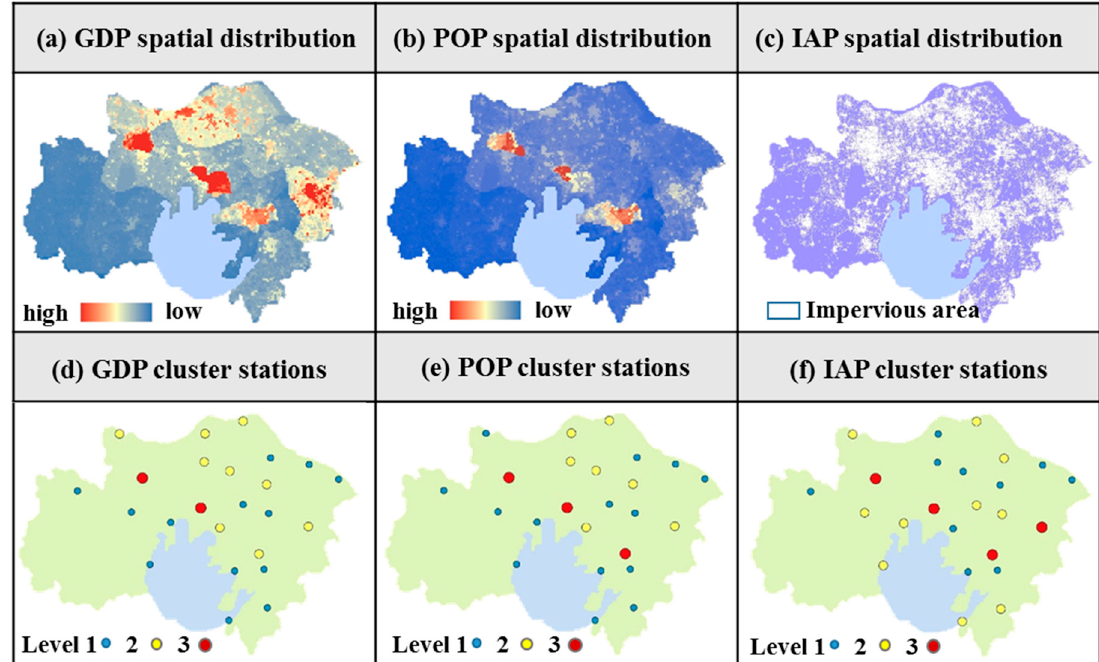
Figure 3. The spatial distributions of gross domestic product (GDP) ( a ), population dataset (POP) ( b ), and global artificial impervious area (IAP) ( c ); results of the classification stations: GDP ( d ), POP ( e ), and IAP ( f ).